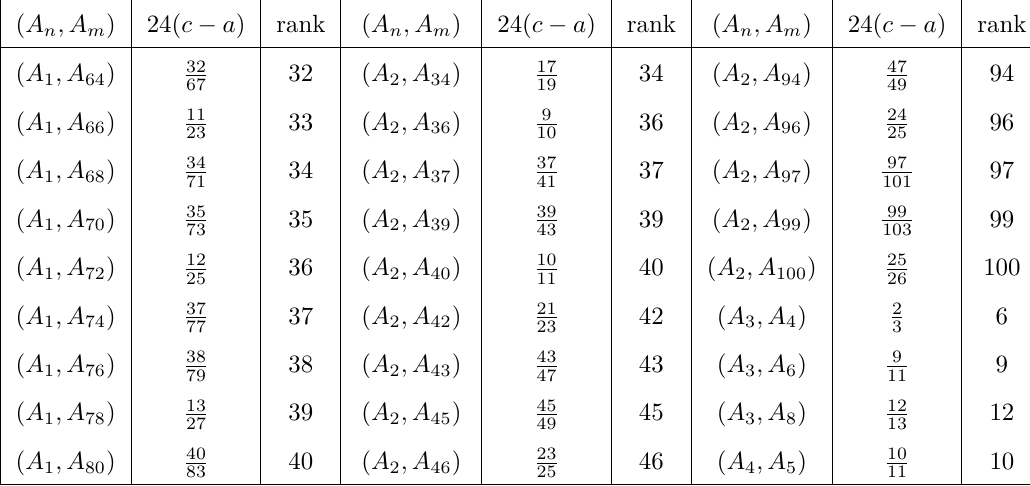
Table 2. ( A n , A m ) with 1 ≤ n, m ≤ 100